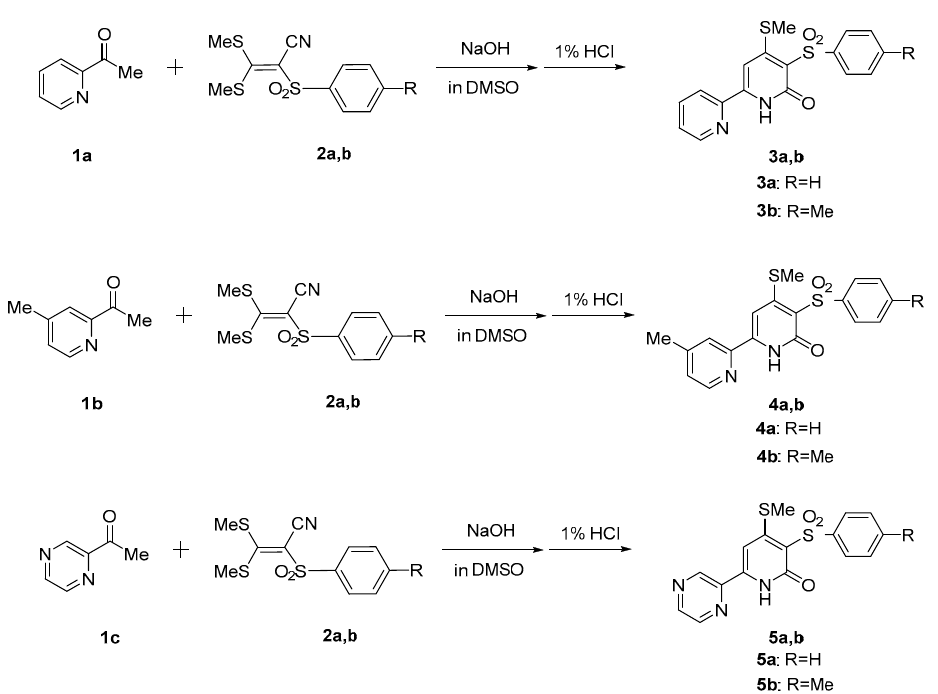
Scheme 1. Synthesis of compounds 3a,b , 4a,b, and 5a,b .